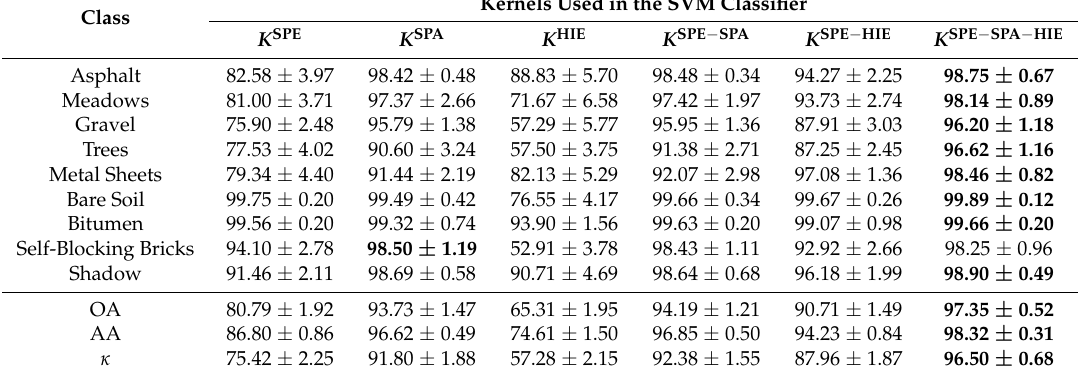
Table 4. Classification Results [Mean Accuracy (%) ± Standard Deviation] by the SVM Classifier with the Spectral, Spatial and Hierarchical Kernels for the UP Image. The best accuracies are indicated in bold in each